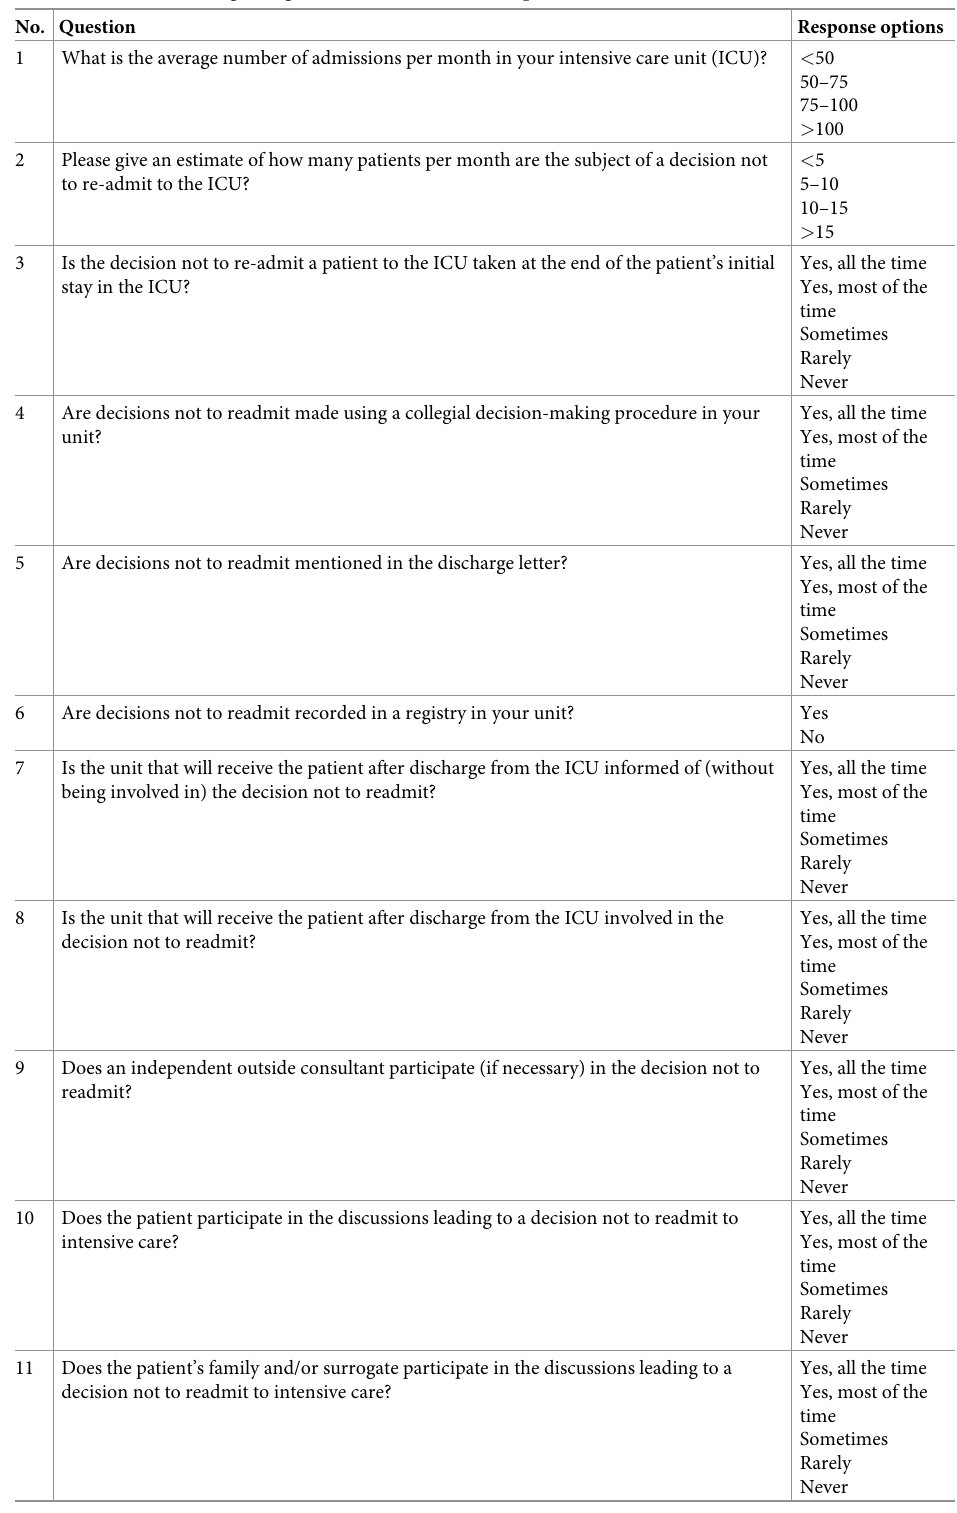
Table 1. Questionnaire regarding decisions not to re-admit a patient to the intensive care